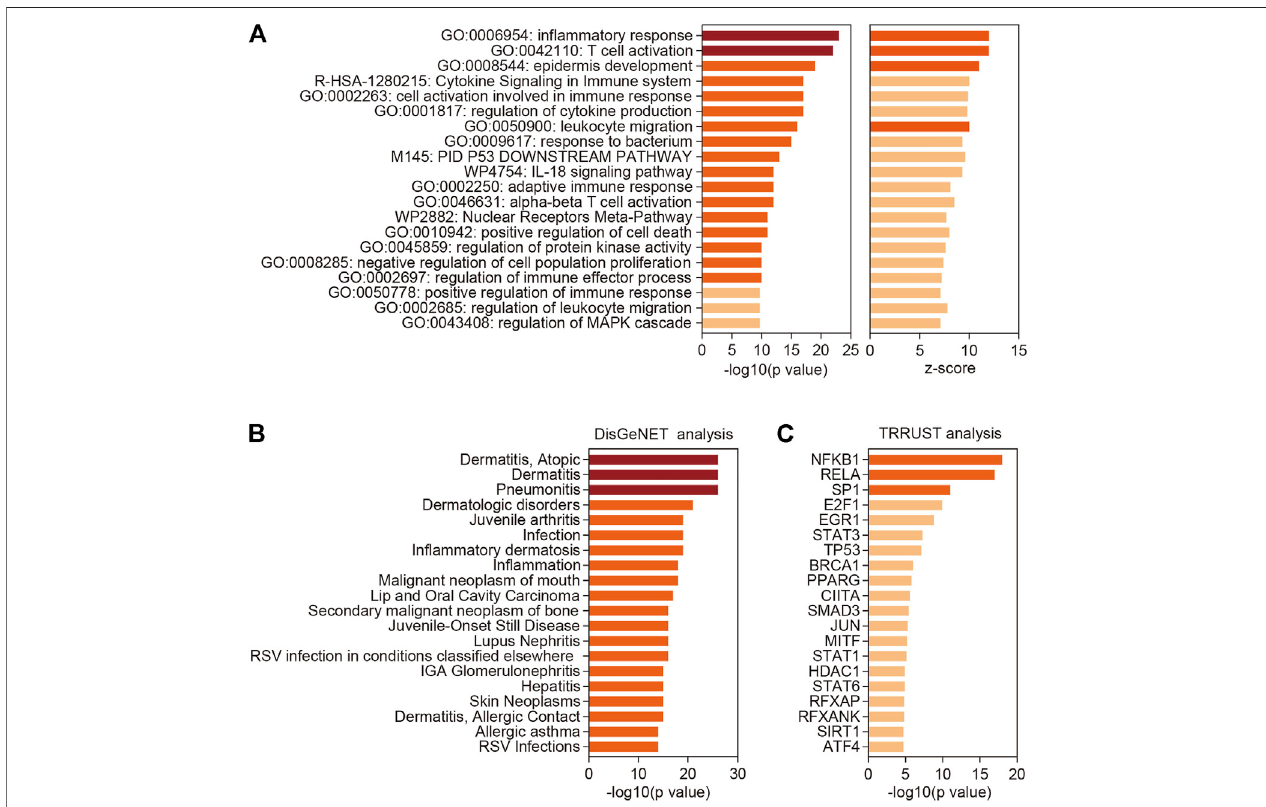
FIGURE 2 | Functional enrichment and annotation analysis. (A) Top 20 categories enriched by Metascape analysis with all differentially expressed coding genes. p -valueswerecalculatedbasedontheaccumulativehypergeometricdistribution. (B) SummaryofenrichmentanalysisinTRRUST(http://www.grnpedia.org/trrust/). (C) Summary of enrichment analysis in DisGeNET (http://www.disgenet.org/). Dark red, -log 10( p value) > 20; orange, 10 < -log 10( p value) < 20 or z-score > 10; shallow orange, -log 10( p value) < 10 or z-score < 10.